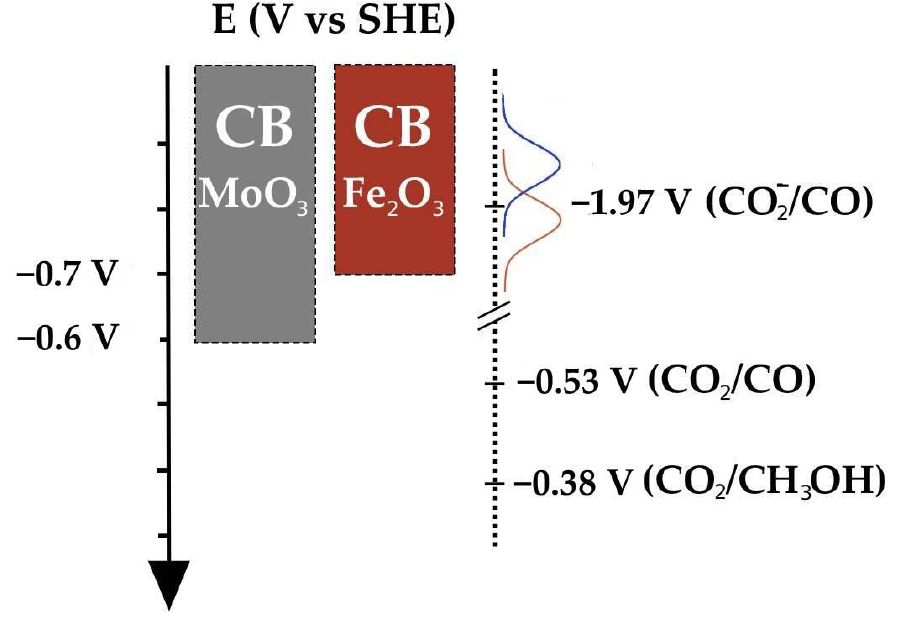
Scheme 1. Representation of the conduction band position measured by flat band potential determination and some CO 2 redox couples related with the onset of the faradic currents.